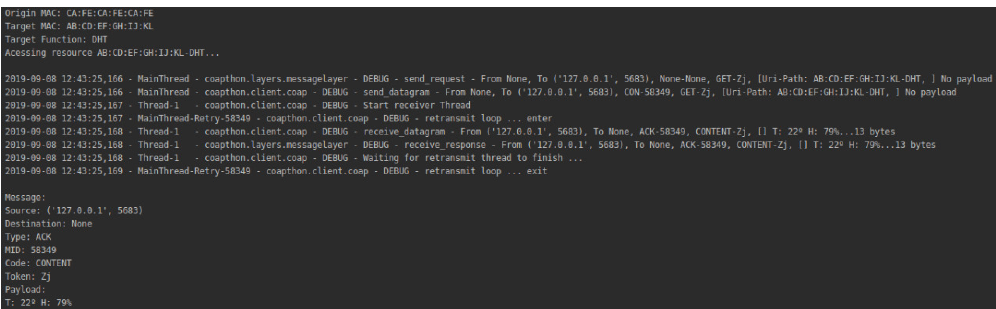
Figure 9. User communication with a device authorized by blockchain.